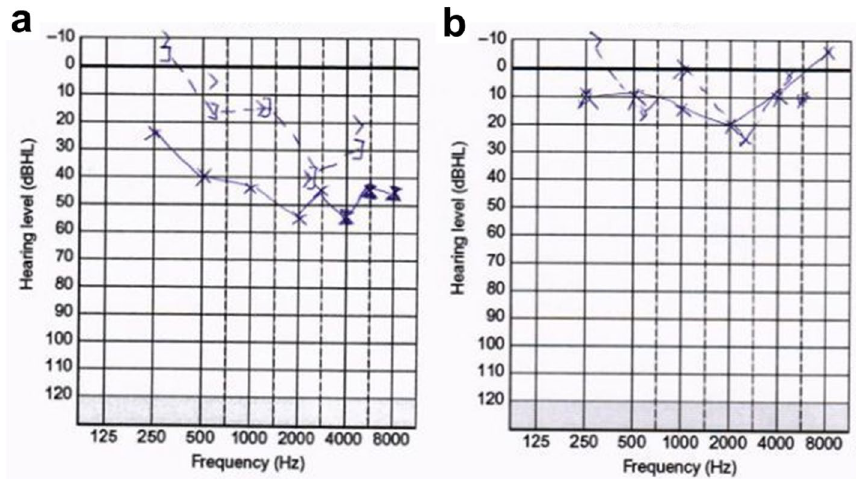
Fig. 2 a Baseline pure tone audiometry upon the first presentation to otorhinolaryngology clinic showing a mixed hearing loss. b Pure tone audiometry after completion of anti-tuberculous